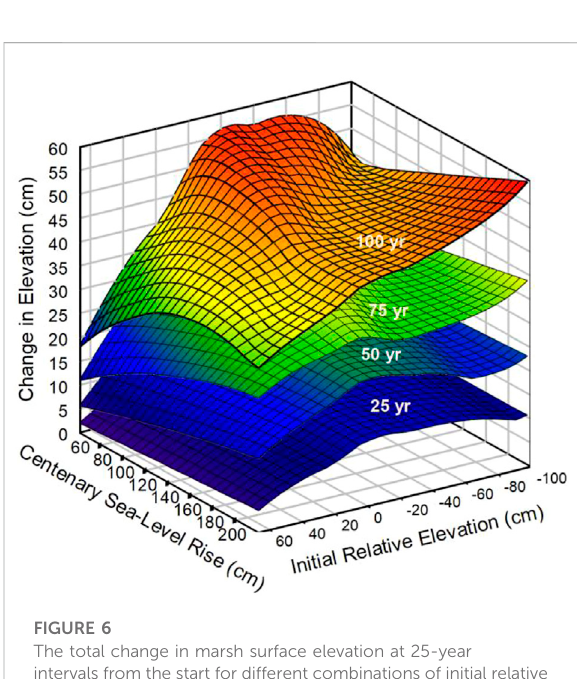
FIGURE 6 The total change in marsh surface elevation at 25-year intervals from the start for different combinations of initial relative elevation and centenary sea-level rise. See Supplementary Figure S3 for